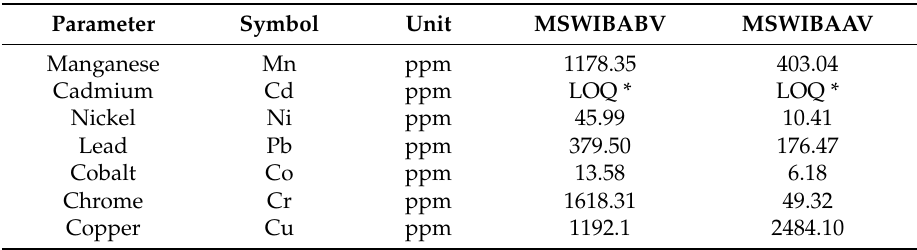
Table 8. Heavy metals in MSWIBABV and MSWIBAAV. Parameter Symbol